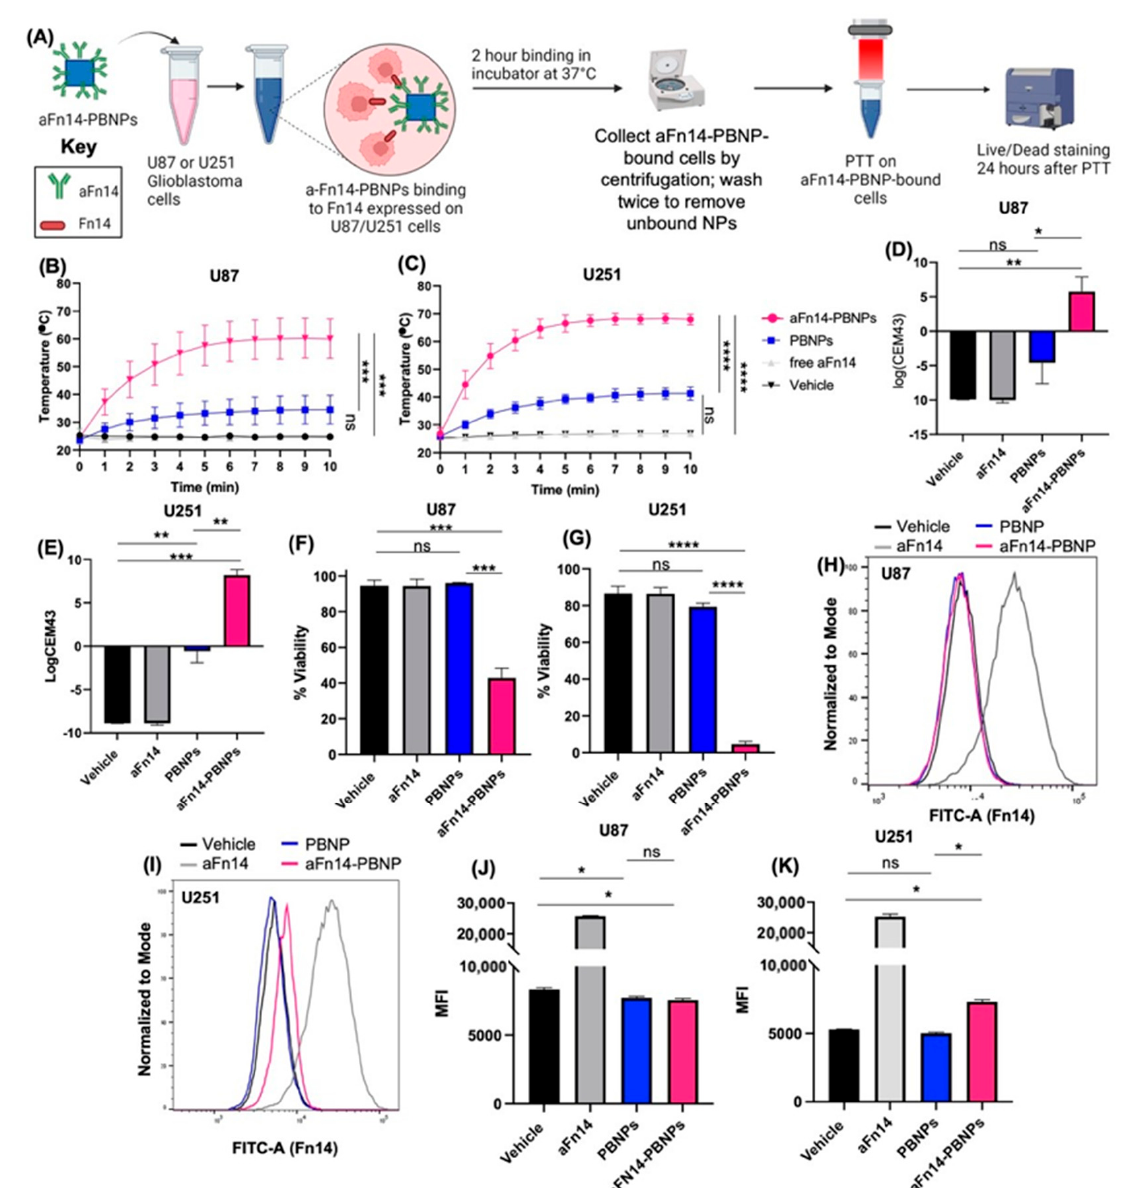
Figure 5. aFn14-PBNP is an effective targeted PTT agent for GBM tumor cells. ( A ) Experimental setup schematic, described in Methods 2.10: U87 or U251 cells were incubated with PBNPs, aFn14-PBNPs, free FITC-conjugated aFn14, or a vehicle control (water) for 2 h at 37 °C. Cells were then washed to remove unbound particles and irradiated with an 808 nm laser. Cells were plated for 24 h and analyzed via flow cytometry for viability. ( B , C ) Heating curves of U251 and U87 cell lines during PTT. ( D , E ) Thermal doses imparted on the cell lines during PTT. ( F , G ) Viability of tumor cells 24 h post-PTT. ( H – K ) Flow cytometric analysis done just before PTT of aFn14 binding in U87 and U251 cells. ( H , J ) No aFn14 binding is detectable in the aFn14-PBNP condition in U87 cells as indicated by the lack of a population shift or increase in MFI from the vehicle control to the aFn14-PBNP condition. ( I , K ) Some aFn14 is detectable in the aFn14-PBNP condition in U251 cells as indicated by a population shift and increase in MFI. ( B – K ) More aFn14-PBNPs remained bound to the U251 cells than to the U87 cells, which is reflected in the higher heating curves, thermal dose, and lower viability in this cell line ( B – G , I , K ) A one-way ANOVA was used to test for significance using Tukey’s HSD test for multiple comparisons. * = p < 0.05 ** = p < 0.01 *** = p < 0.001 **** = p < 0.0001. ns = not